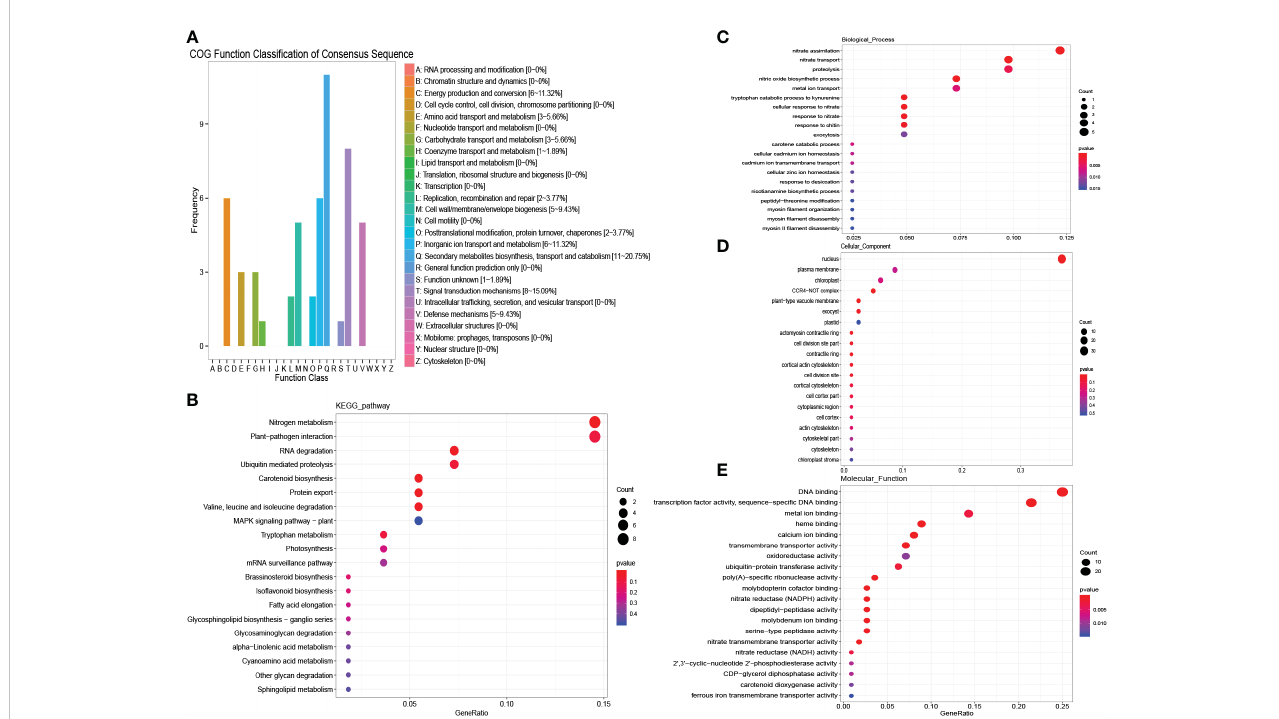
FIGURE 7 COG, KEGG and GO analysis of female unique salinity stress responding genes. (A) COG enrichment analysis of female unique salinity stress responding genes. (B) KEGG enrichment analysis of female unique salinity stress responding genes. (C – E) GO enrichment analysis of female unique salinity stress responding